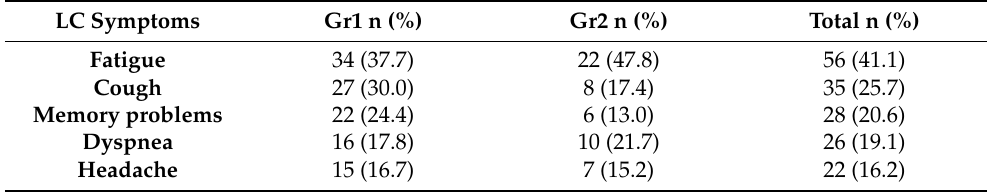
Table 2. The most commonly reported LC symptoms experienced by